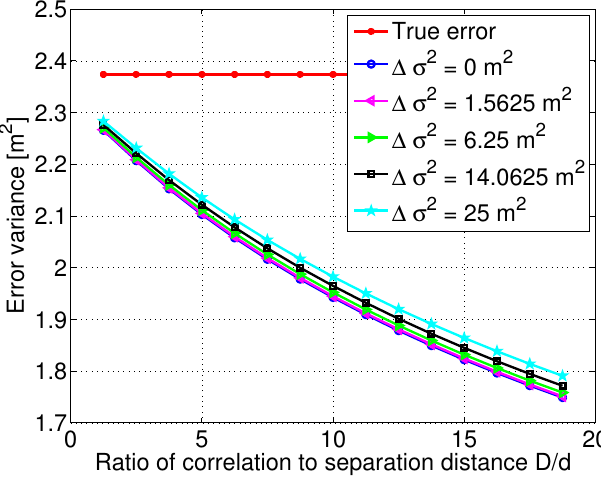
Figure 10. Estimation error variance corresponding to a sum of three Gauss-Markov processes and different ∆ σ 2 modeling